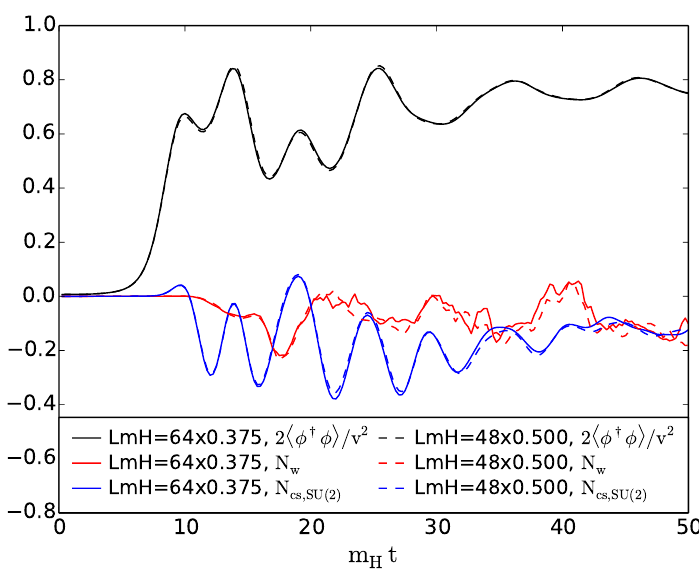
Figure 8 . The primary observables (cid:30) y (cid:30) , N